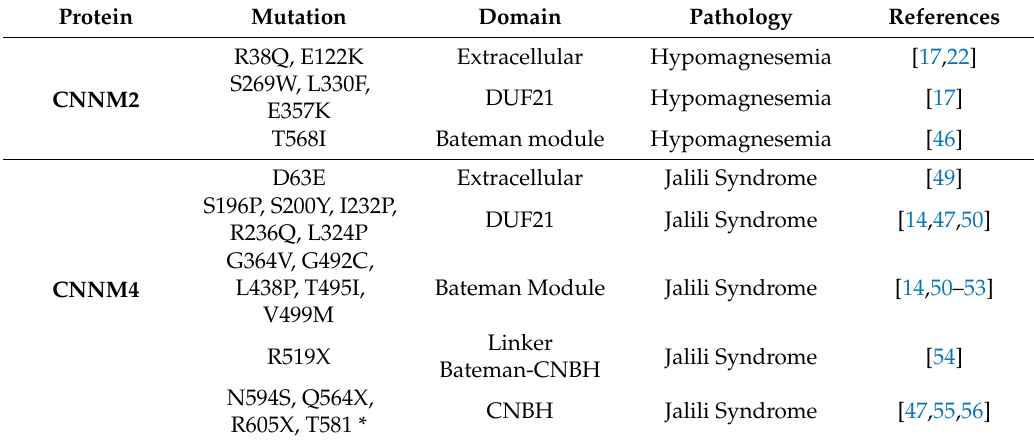
Table 2. Pathological mutations found in CNNMs identified in patients. Asterisk indicates a premature stop codon. “X” indicates the amino acid after which the protein is truncated. CNBH refers to cyclic-nucleotide-binding homology